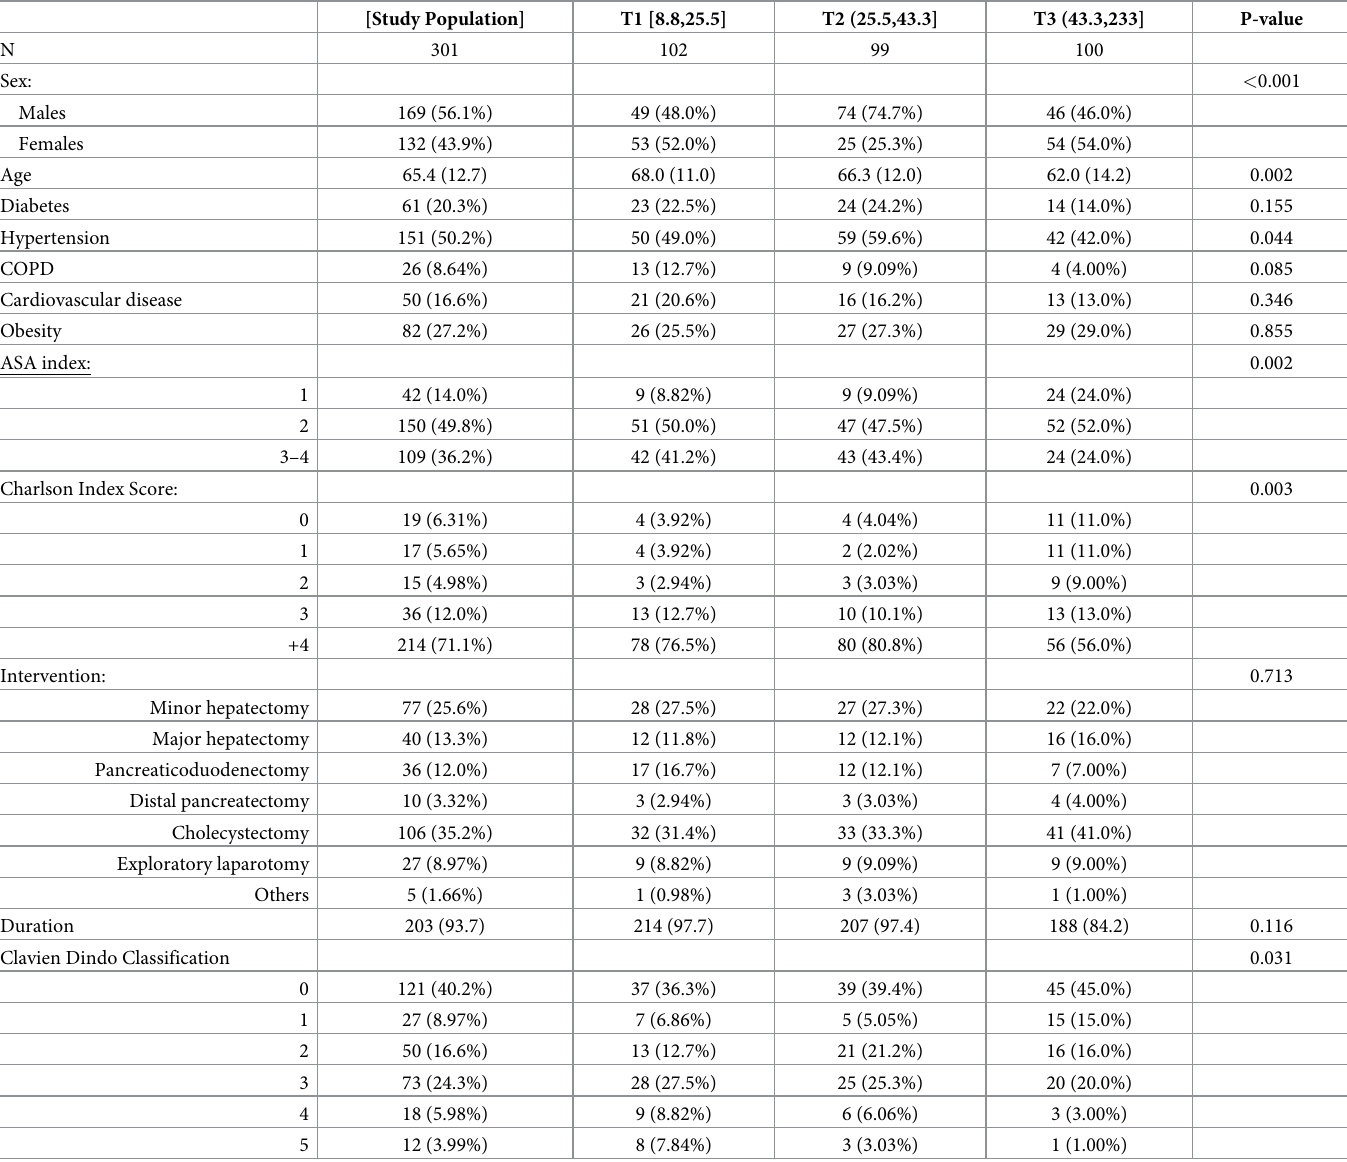
Table 1. Demographic data and baseline medical conditions for 301 patients, stratified by tertiles (T) of serum vitamin D